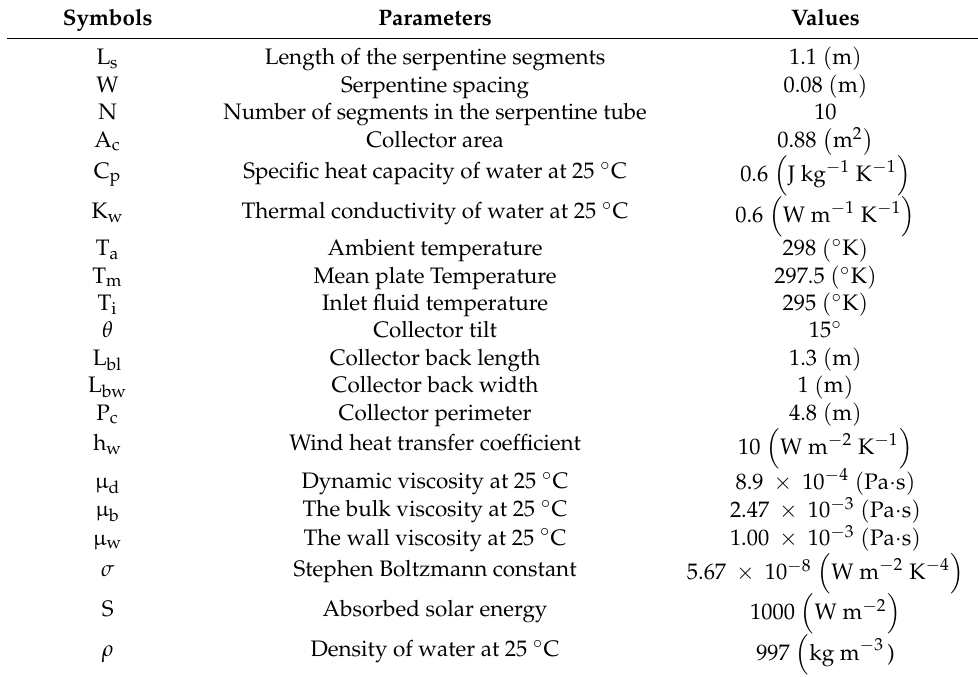
Table 3. Values of different parameters to determine